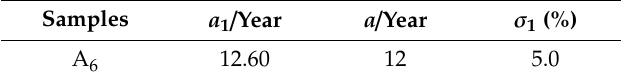
Table 10. Predicted and actual aging time of composite insulators.